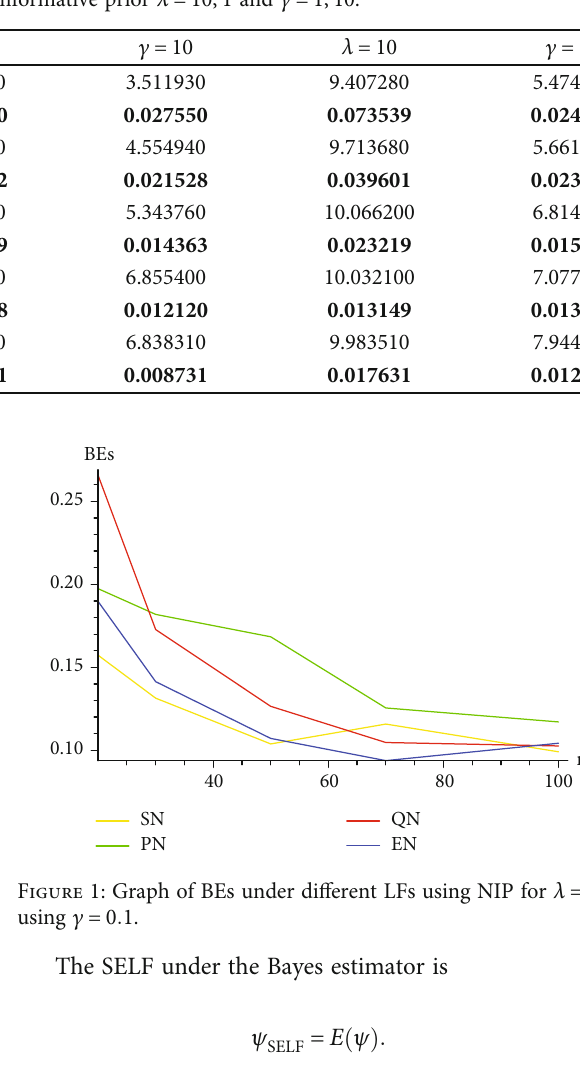
Table 11: BEs and PRs under ELF and informative prior λ = 10, 1 and γ = 1, 10 .